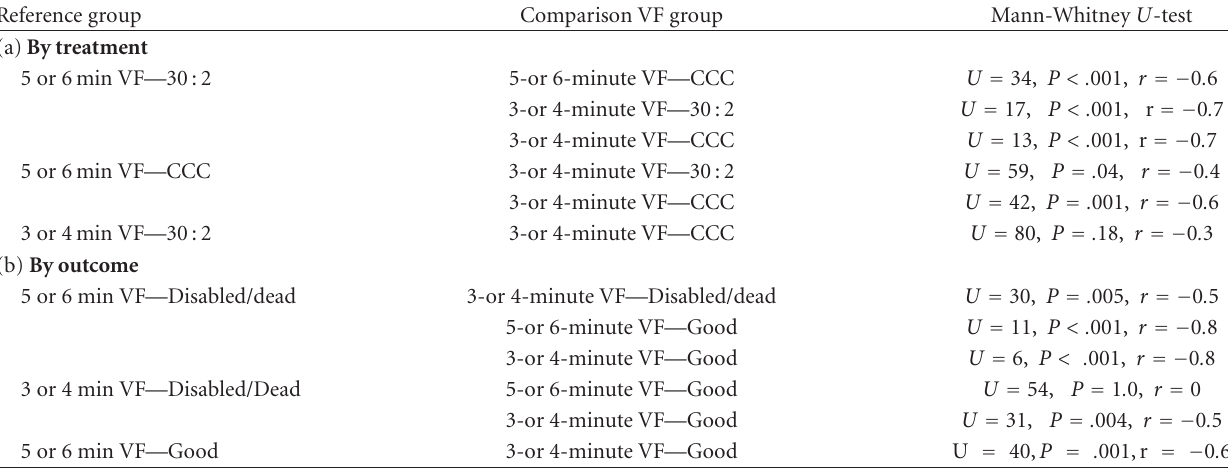
Table 2: (a) Frequency of gasping in relation to the resuscitation protocol applied. (b) Frequency of gasping in relation to the 24-hour neurological outcome.